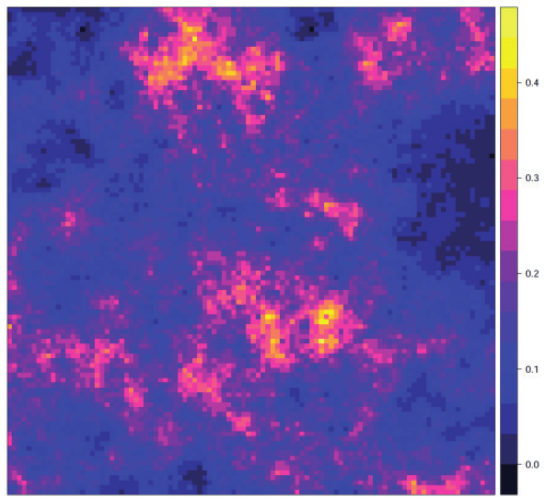
Figure 3. Distribution of simplified risk obtained as product of the simplified distributions of hazard, exposure and vulnerability as de- scribed in Equation